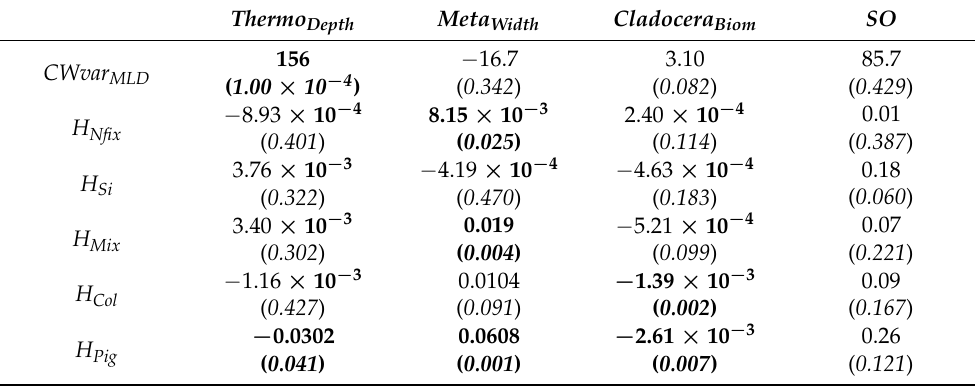
Table 2. Results of the permuted multiple linear regressions on the different trait diversity indices. For each regression, the coefficients for each potential explanatory factor (from left to right: Thermocline depth , Metalimnion width , Zooplankton biomass and Spatial Overlap ) are indicated along with associated p -values in parentheses. Significant coefficients and p -values are indicated in